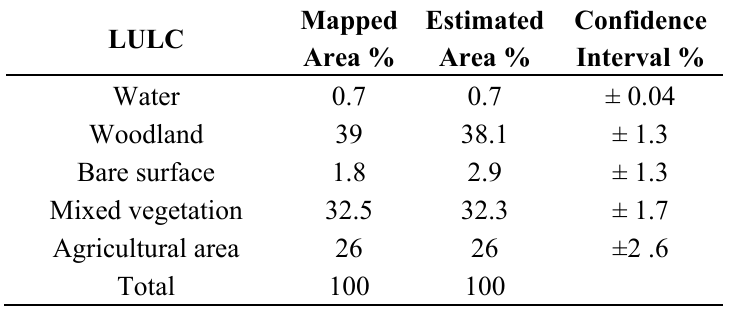
Table 16. Proportion of LULC types in 2006.